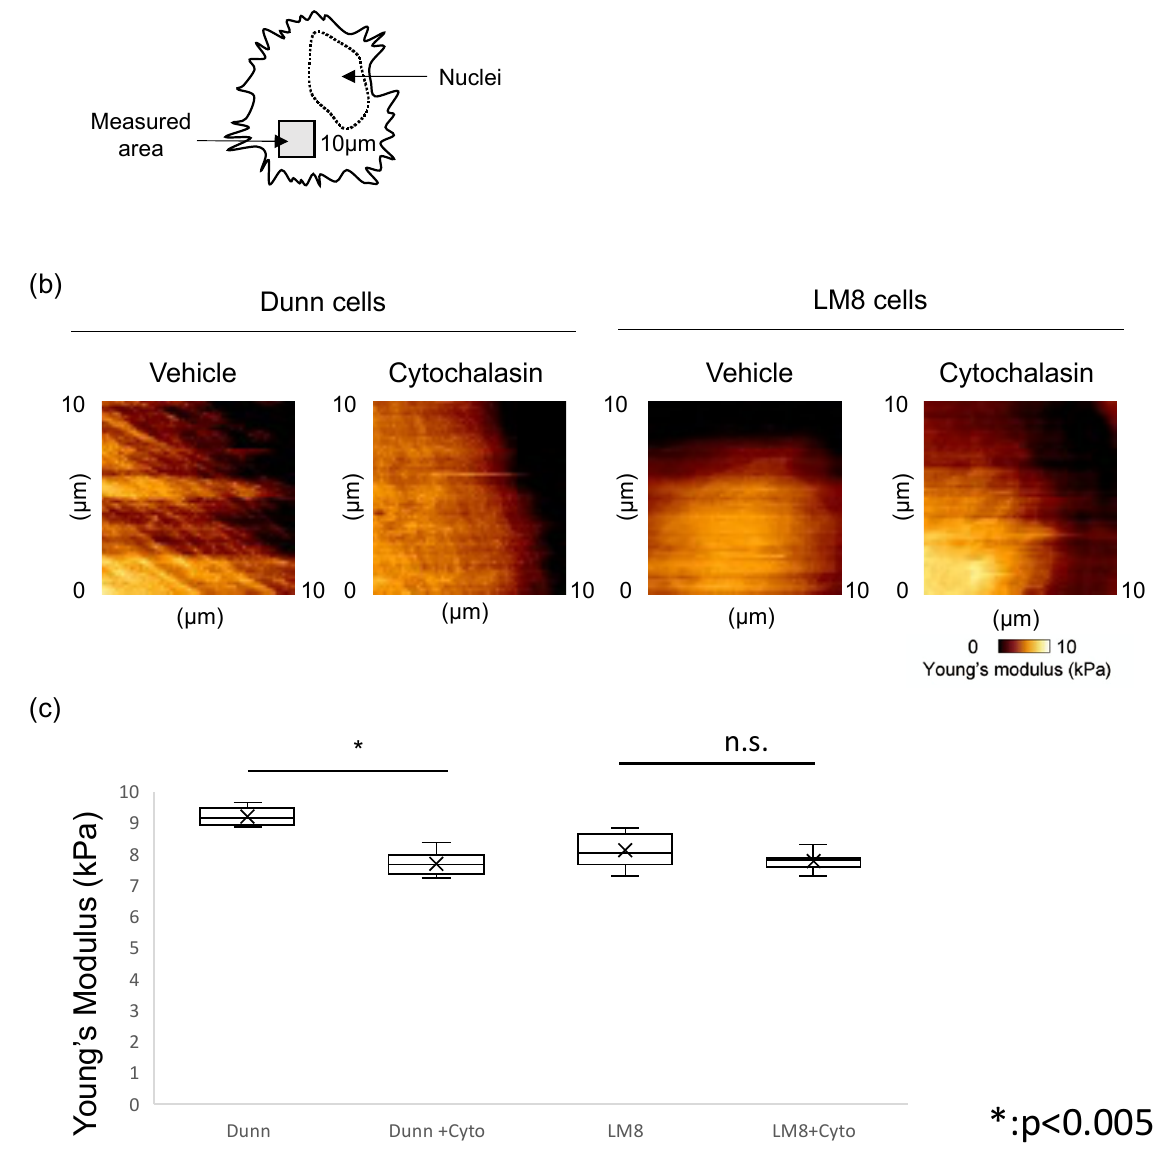
Figure 3. Change of Young’s modulus by cytochalasin. ( a ) Measured area by AFM was indicated in the scheme. ( b ) Young’s modulus images in Dunn ( left ) and LM8 ( right ) with or without cytochalasin were shown. ( c ) Young’s modulus was compared between Dunn and LM8 with or without cytochalasin. Dunn ( − : 9.20 ± 0.27 kPa, +: 7.69 ± 0.35 kPa, p < 0.005), LM8 ( − : 8.11 ± 0.51 kPa, +: 7.77 ± 0.26 kPa, * p < 0.005, n.s.: not significant).